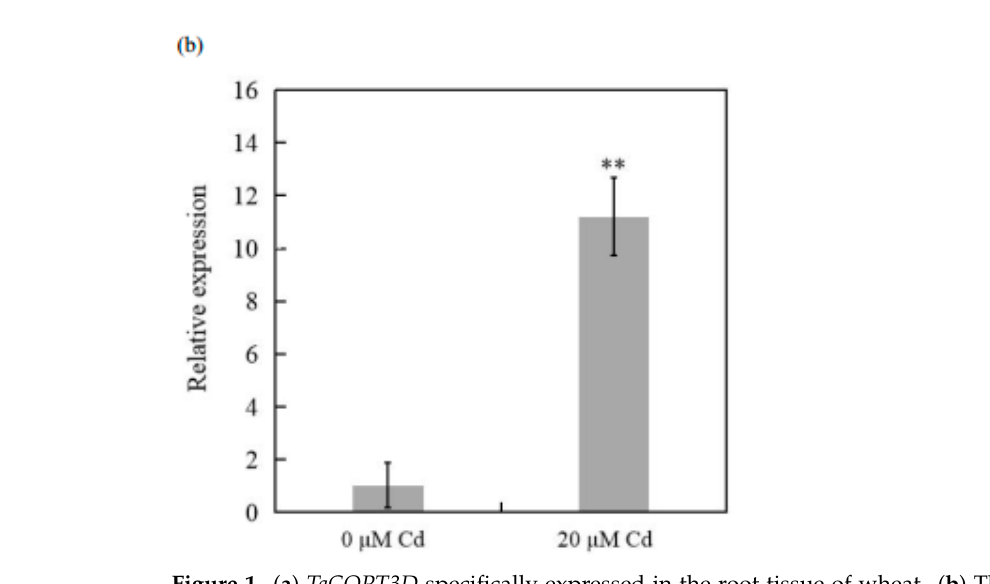
Figure 1. ( a ) TaCOPT3D specifically expressed in the root tissue of wheat. ( b ) The expression of TaCOPT3D in the root tissue was highly induced by Cd stress. ** Significant differences at p ≤ 0.01.